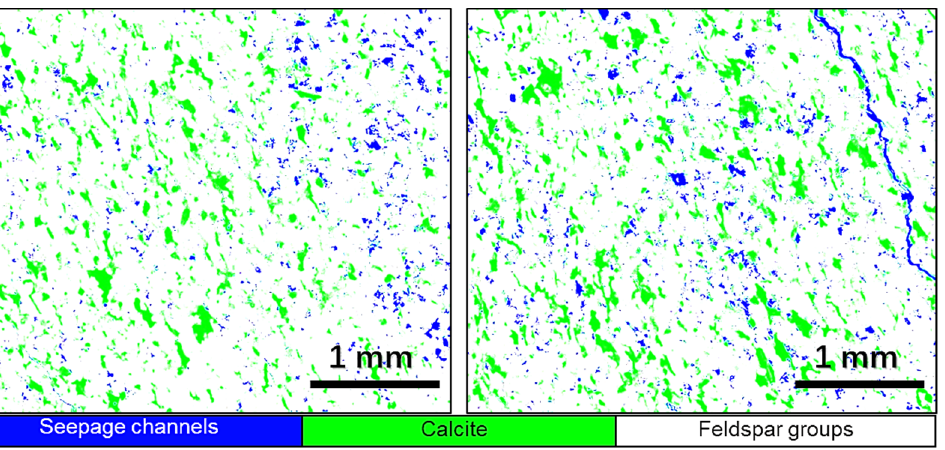
Figure 5. Identification of pore and main mineral types in tight rock reservoirs.